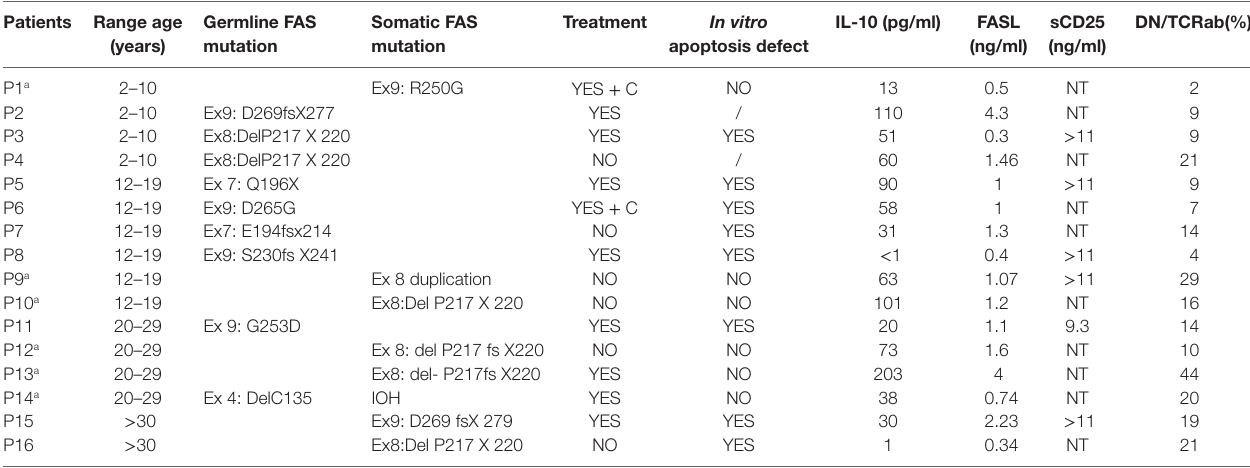
Table 1 | Clinical and genetic features of 16 ALPS patients. Patients range age germline Fas (years)